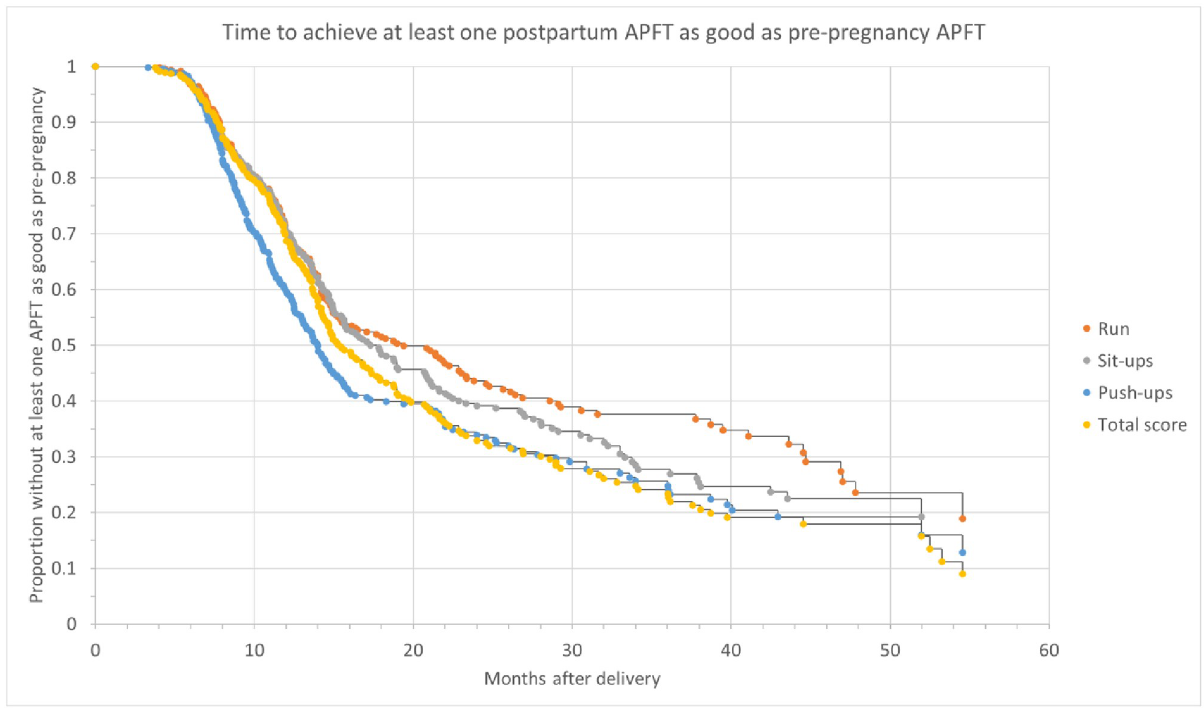
Fig 4. Kaplan-Meier estimates of time to achieve postpartum individual APFT event and overall APFT score equal to or greater than the last pre- pregnancy APFT. APFT, Army Physical Fitness Test.